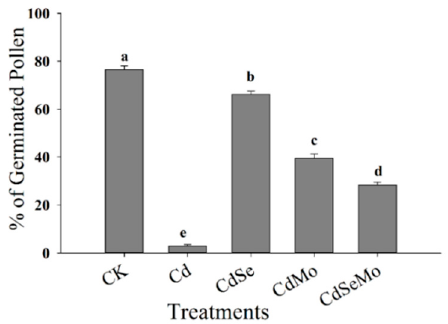
Figure 10. In vitro germination (%) of pollen grains under Cd stress. Pollens are germinated in a culture medium contains polyethylene glycol 4000 (20%) and sucrose (5%) under 500 µM Cd in the presence of Se (10 µM) and/or (1 µM) Mo. Different letters indicate significant differences at ( p < 0.05).